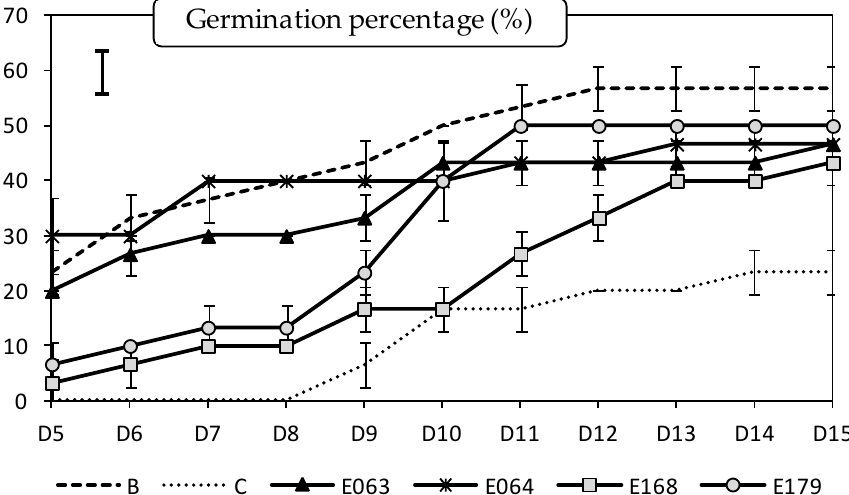
Figure 2. Effect of endophytic extracts on the germination percentage of Lupinus luteus seeds inocu- lated with Phytophthora cinnamomi over 11 measurements (from 5 to 15 days). Values are expressed as mean ( n = 16) ± standard error (error bars). The bar in the upper-left corner indicates the least significant difference (LSD) at α = 0.05. B (blank): seedling receiving no extract nor Phytophthora inoculation. C (control): Phytophthora —inoculated seeds receiving no